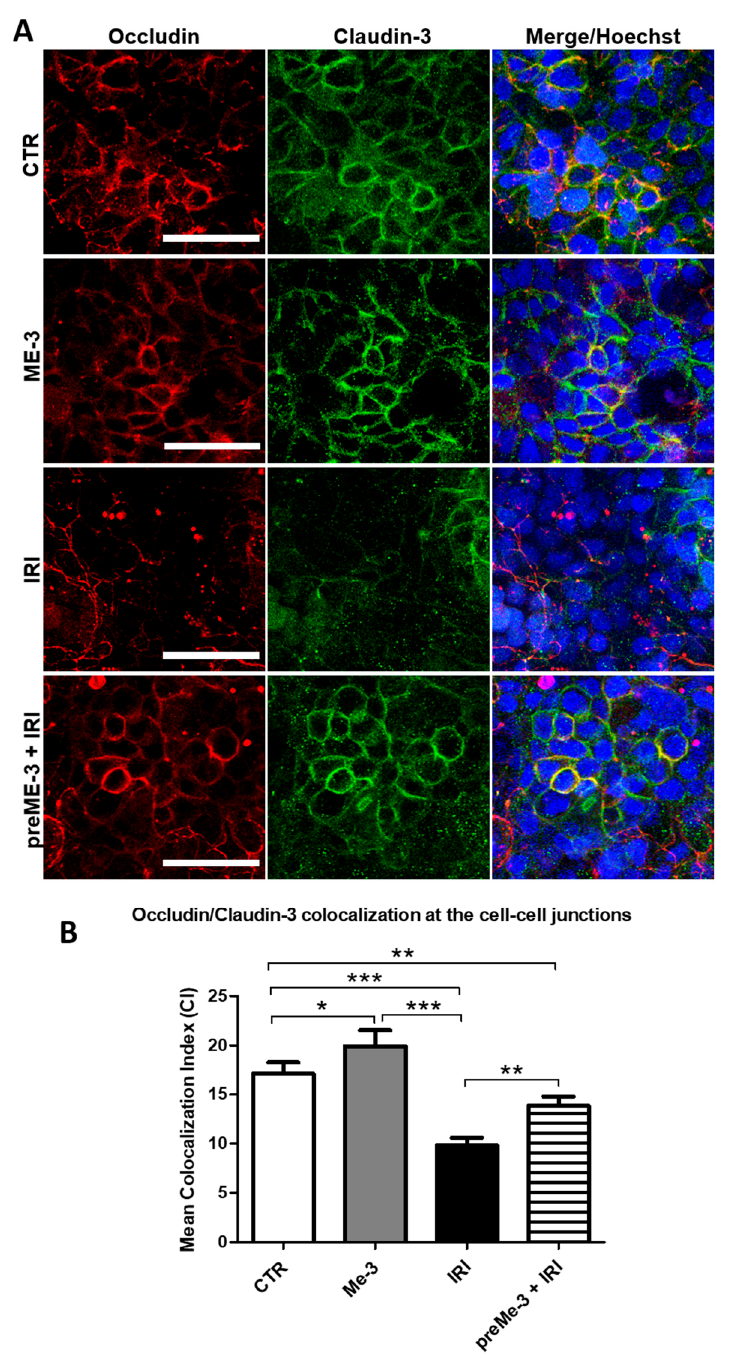
Figure 3. Effects of L. fermentum ME-3 ® on the expression and localization of proteins involved in tight junction (TJ) functionality. ( A ) Confocal microscopy showing the double immunofluorescence staining of Occludin (red hue) and Claudin-3 (green hue), performed as described in the MM section, in controls (untreated and ME-3 ® treated cells) and IRI-treated cultures grown in the presence or absence of ME-3 ® pretreatment. The colocalization at the cell–cell contact of the two TJ components is represented by the yellow hue. Cell nuclei were counterstained with 0.2% Hoechst. Bars = 50 µm. The bar graph in ( B ) reports the mean Occludin/Claudin-3 colocalization indexes (CIs), calculated as described in the Materials and Methods, for controls and treated cells. Quantification of CIs was carried out by analyzing a minimum of 100 cells/sample, and the results are the means ± SDs from three independent experiments ( n = 3). Significance (one-way ANOVA + Tukey’s multiple comparison test): * p < 0.05, ** p < 0.01, *** p < 0.001.